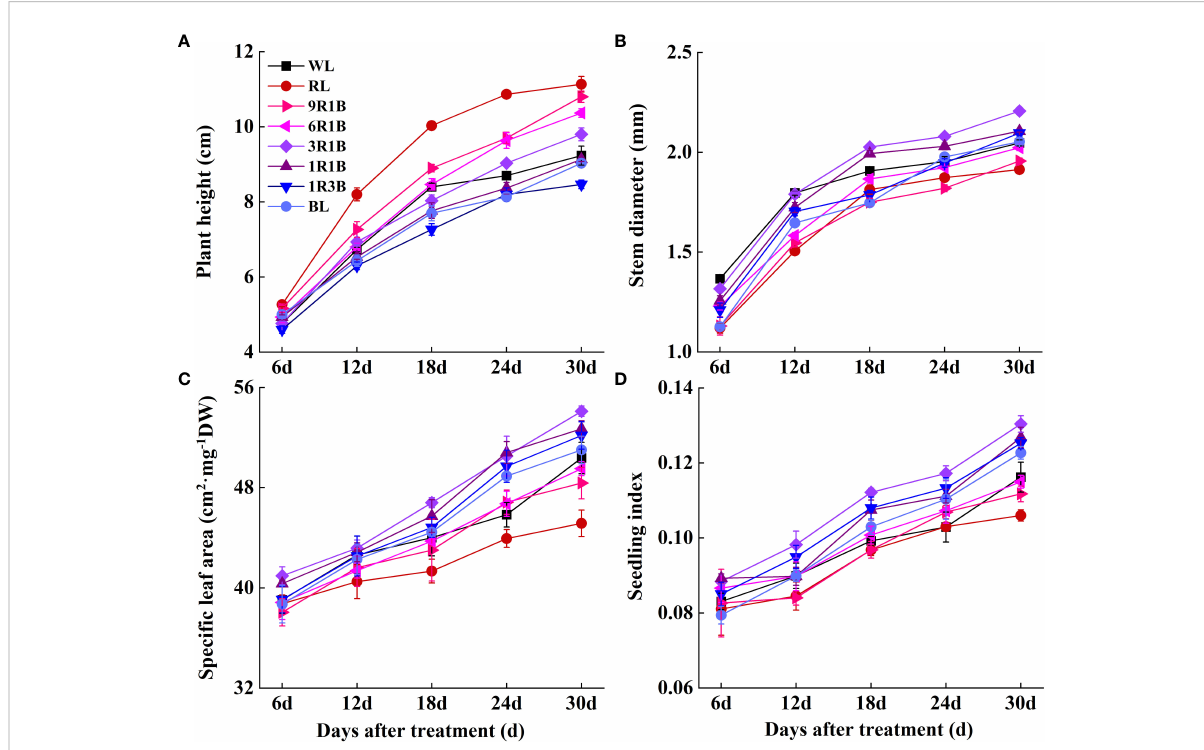
FIGURE 3 Effect of monochromatic and mixed red and blue light on growth of sweet pepper seedlings throughout 30 days after treatment. (A) plant height; (B) stem diameter; (C) speci fi c leaf area; (D) seedling